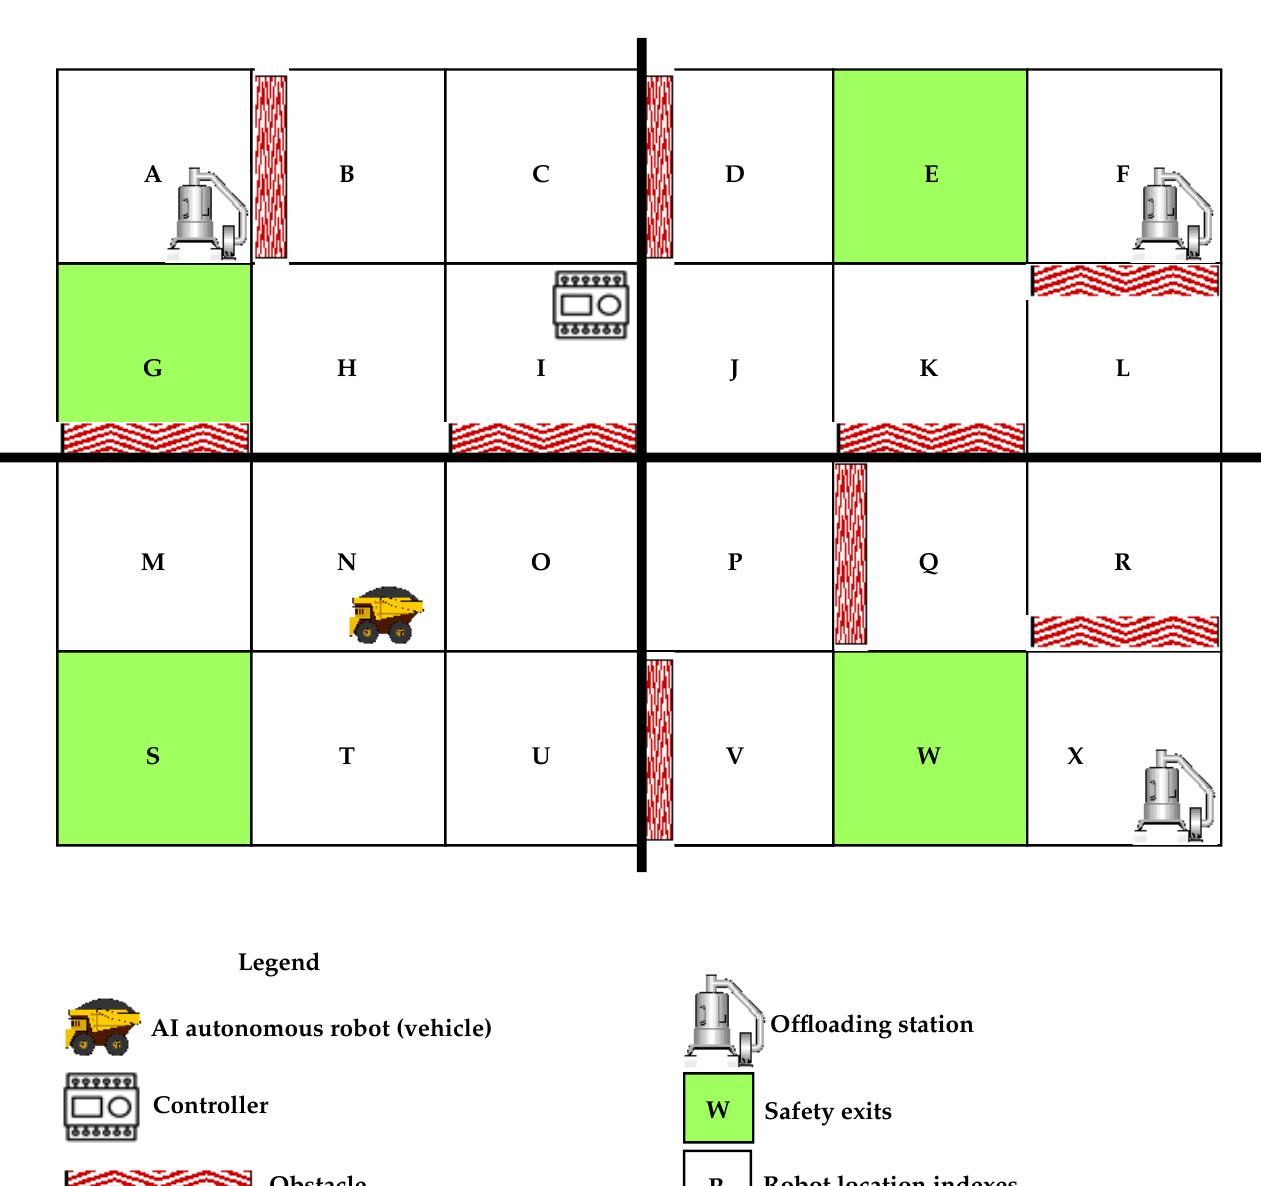
Figure 1. Experimental manufacturing environment for autonomous moving robot